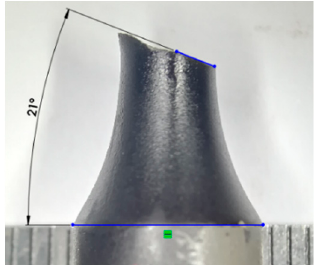
/ torsion fatigue at Figure 22. Specimen failed by tension/torsion fatigue at VHCF. Figure 22. Specimen failed by tension/torsion fatigue at VHCF. Figure 22. Specimen failed by tension